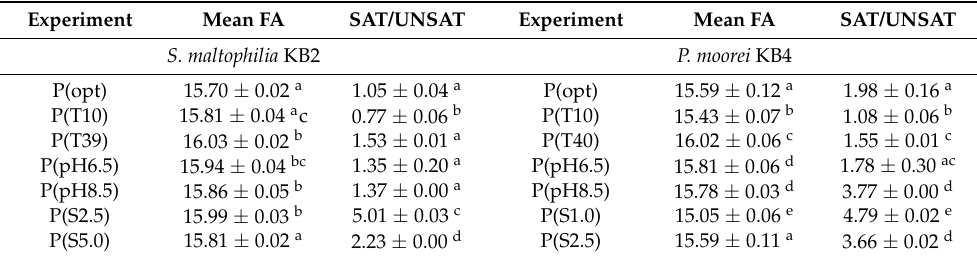
Figure 4. The correlation of fatty acids isolated from S. maltophilia KB2 (A) and P. moorei KB4 (C) with PC1 and PC2 and the projection of FAME profiles of S. maltophilia KB2 (B) and P. moorei KB4 (D) growing under different culture conditions on the plane defined by PC1 and PC2. Table 3. Mean fatty acid chain length (Mean FA) and the ratio of saturated to unsaturated fatty acids (SAT/UNSAT) for S. maltophilia KB2 and P. moorei KB4 grown on phenol under various culture conditions.